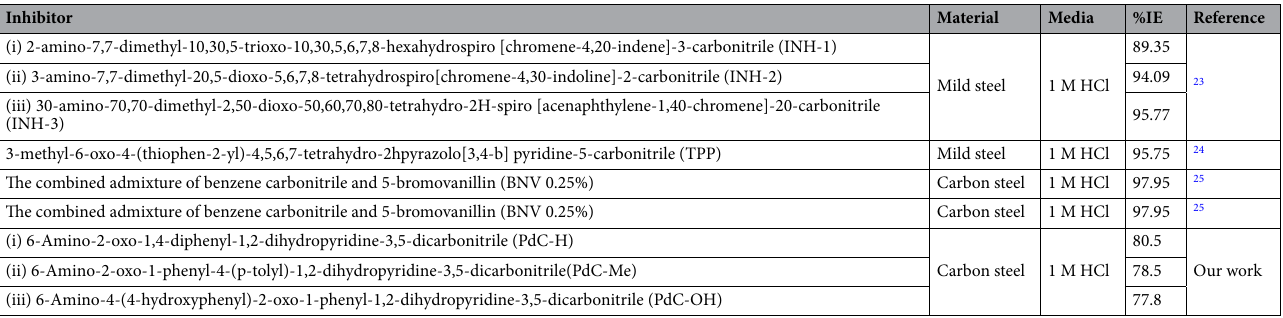
Table 1. %IE of some carbonitrile compounds in 1 M HCl and for steel